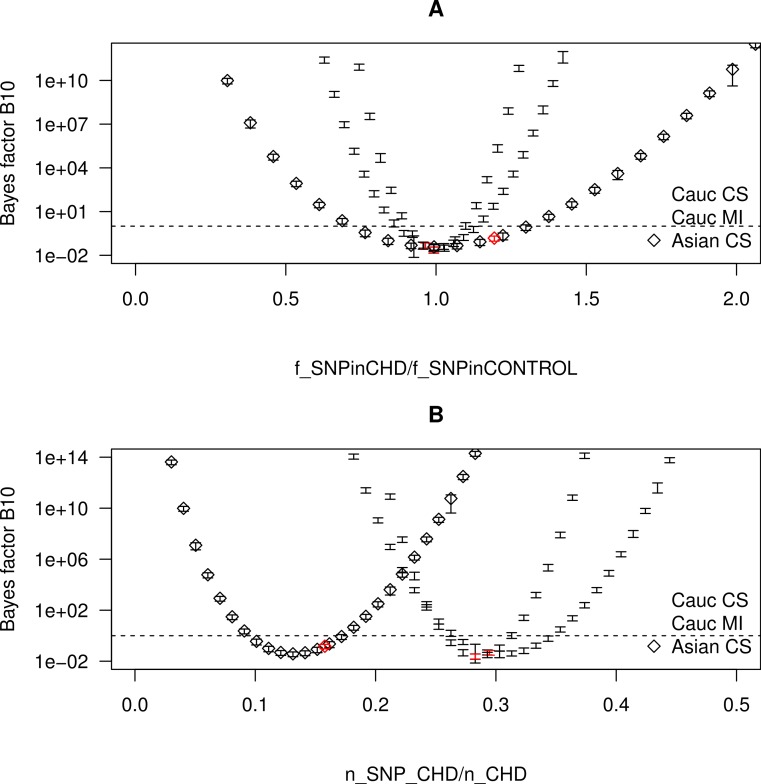
Bayes factor as a function of the frequency of SNP in the CHD populations.The Bayes factor for several realizations of CHD populations with the same nCHD but with different fractions of SNP, grouped by ethnicity and CHD phenotype. The realizations that correspond to a real combined data set are marked as red points. The dashed horizontal line marks the Bayes factor equal to one. (A) The Bayes factor as a function of \documentclass[12pt]{minimal}
\usepackage{amsmath}
\usepackage{wasysym}
\usepackage{amsfonts}
\usepackage{amssymb}
\usepackage{amsbsy}
\usepackage{upgreek}
\usepackage{mathrsfs}
\setlength{\oddsidemargin}{-69pt}
\begin{document}
}{}${f}_{\text{SNPinCHD}}/{f}_{\text{SNPin}\overline{\text{CHD}}}$\end{document}fSNPinCHD/fSNPinCHD¯. (B) The Bayes factor as a function of fSNPinCHD.